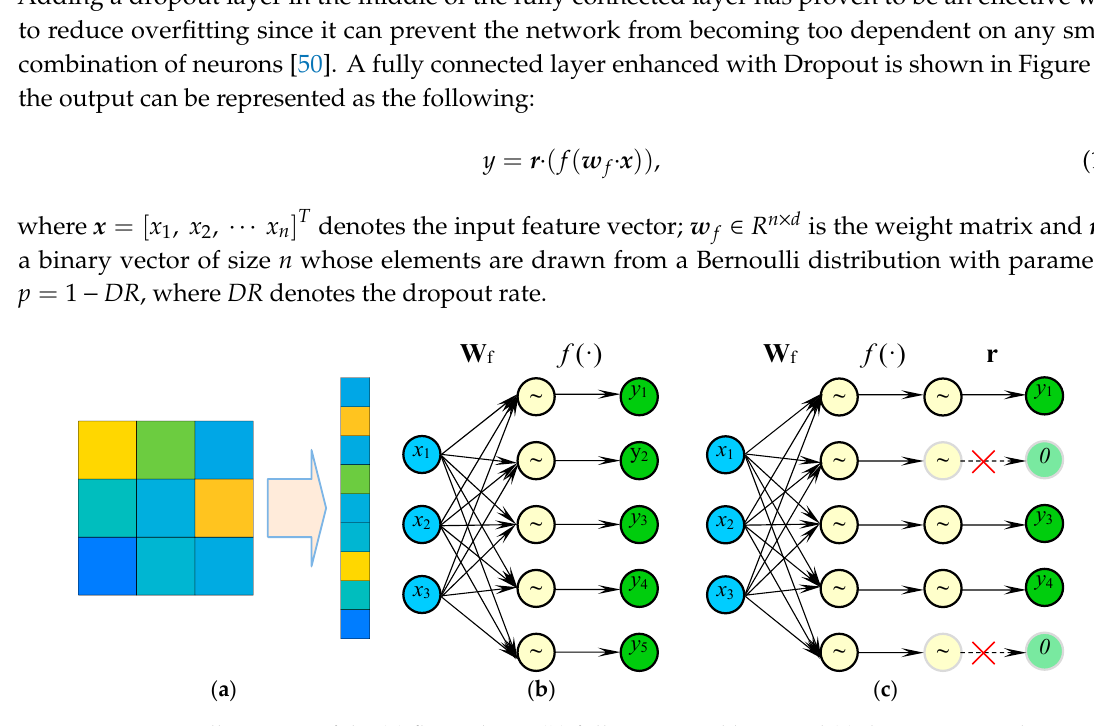
Figure 6. Illustration of the ( a ) flatten layer, ( b ) fully connected layer and ( c ) dropout network.